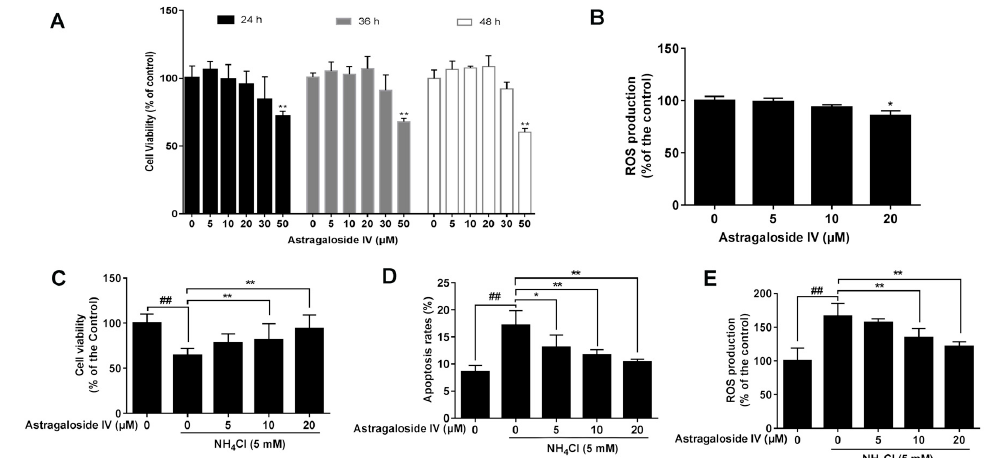
Figure 1. The protective effects of astragaloside IV against ammonia -induced cell death and ROS production in MAC-T cells. ( A ) The effects of different concentrations of astragaloside IV (0, 5, 10, 20, and 50 μ M) for 24 h, 36 h or 48 h on the viability of MAC-T cells. The cell viability was measured by CCK-8 assay. The data are shown as mean ± SD. n = 6. **, p < 0.01. ( B ) The effects of different concentrations of astragaloside IV (0, 5, 10, and 20 μ M) for 24 h on the ROS concentration of MAC-T cells. The data are shown as mean ± SD. n = 4. *, p < 0.05. The MAC-T cells were pretreated with different concentrations of astragaloside IV (0, 5, 10 and 20 μ M) for 4 h, followed by NH 4 Cl (5 mM) treatment for 24 h. The cell viability ( C ), the percentage of cell apoptosis ( D ) and ROS concentration ( E ) were measured. The data are shown as mean ± SD. *, p < 0.05; **, p < 0.01. ## indicates a significant difference from untreated cells ( p < 0.01).